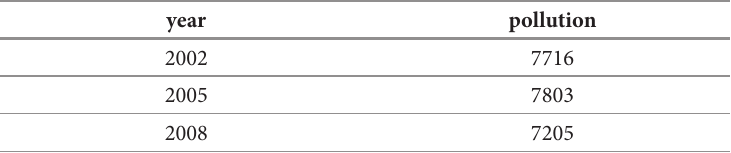
Table 6. Average Pollutant Emission in kilograms per km 2 in the County of